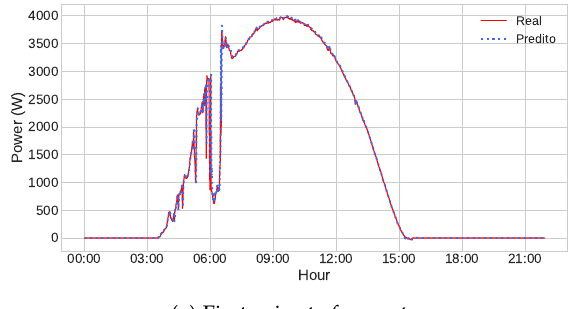
( b ) Fifth-minute forecast. Figure 8. Power forecast by the optimized LSTM model (blue dots) and the actual power values (red line) on the sunny day of 02/07/2022, considering ( a ) the first-minute forecast and ( b ) the fifth-minute forecast.